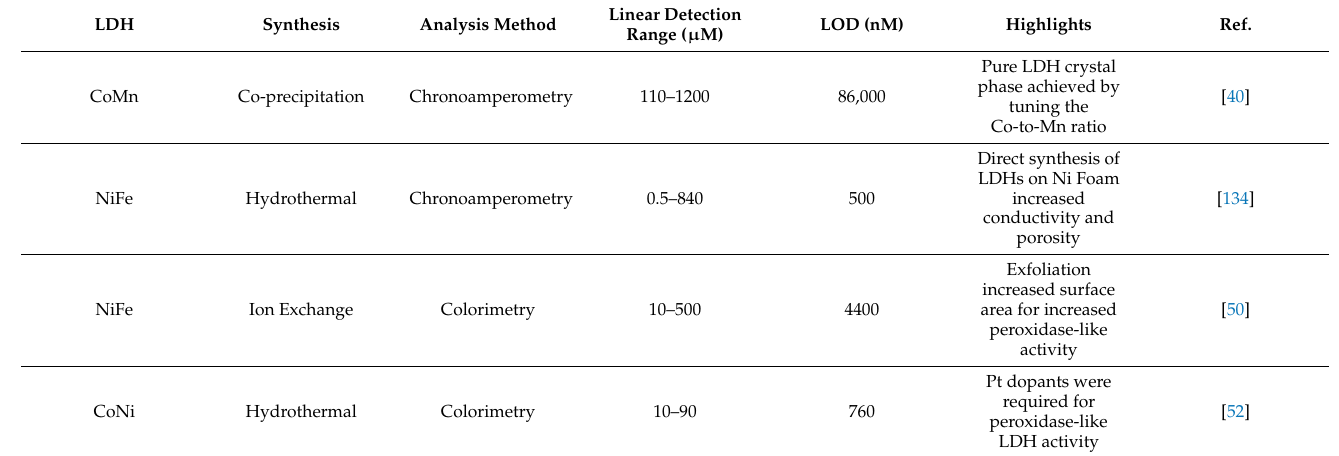
Table 3. The detection performance of LDH-based H 2 O 2